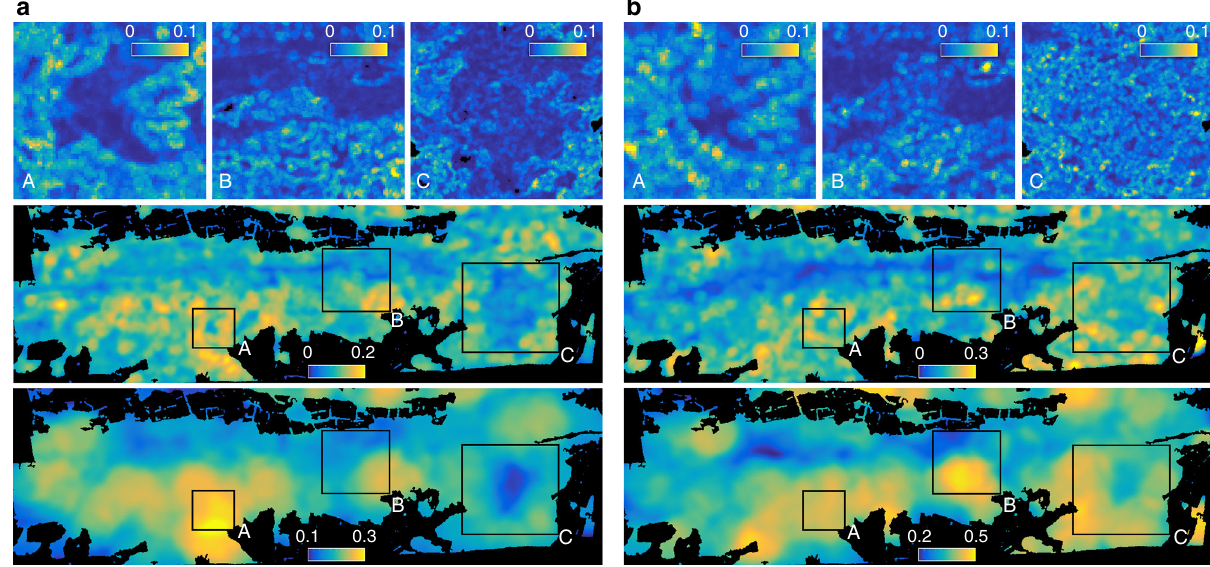
Fig. 5 Spatial patterns of morphological and physiological richness at three different scales. Functional richness was computed at 12 m (top), 60 m (middle) and 240 m (bottom) radius based on a morphological traits and b physiological traits. At 12 m radius (top panels), subregions A, B and C are plotted only. The colour is scaled from the lowest (dark blue) to the highest (yellow) richness value with a maximum possible range from 0 to